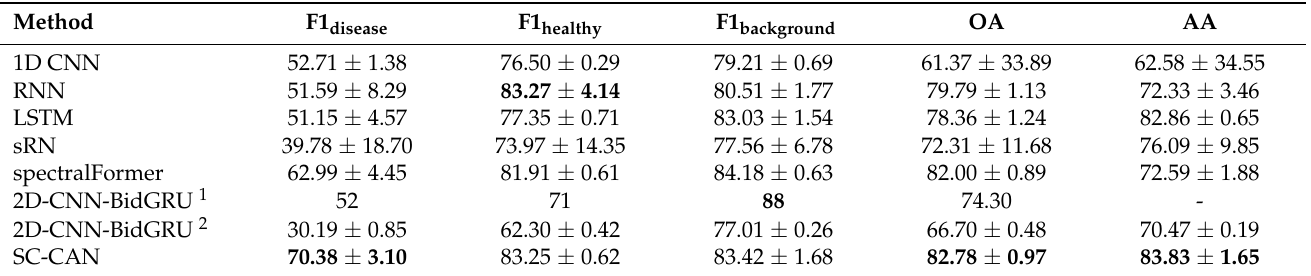
Table 3. Performance comparison between our proposed method and existing methods with Fusar- ium dataset. The numbers in bold show the best